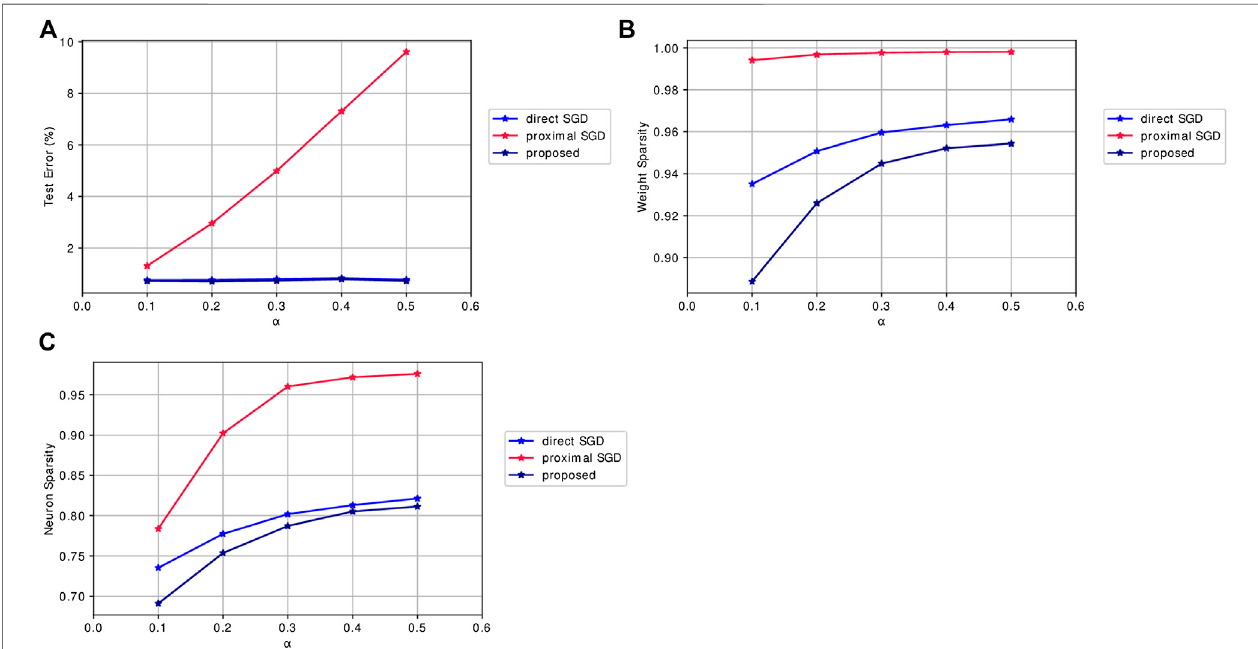
FIGURE 2 | Mean results of algorithms applied to SGL 1 for Lenet-5 models trained on MNIST for 200 epochs across 5 runs when varying the regularization parameter λ (cid:2) α / 60000 when α ∈ { 0 . 1 , 0 . 2 , 0 . 3 , 0 . 4 , 0 . 5 } . (A) Mean test error. (B) Mean weight sparsity. (C) Mean neuron sparsity.